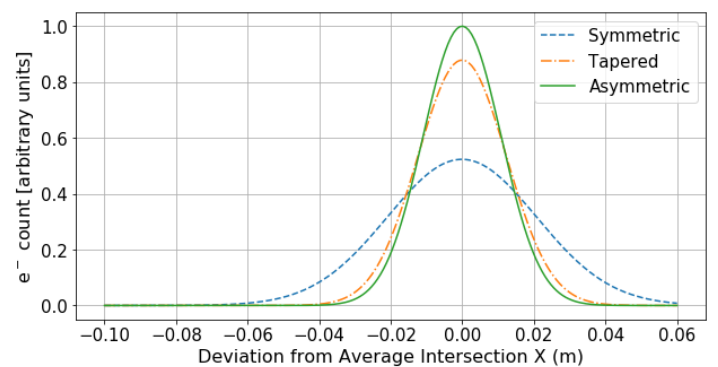
Figure 12. Focusing in three different kinds of einzel lenses. It is clear that the two asymmetrical designs result in a tighter focus.